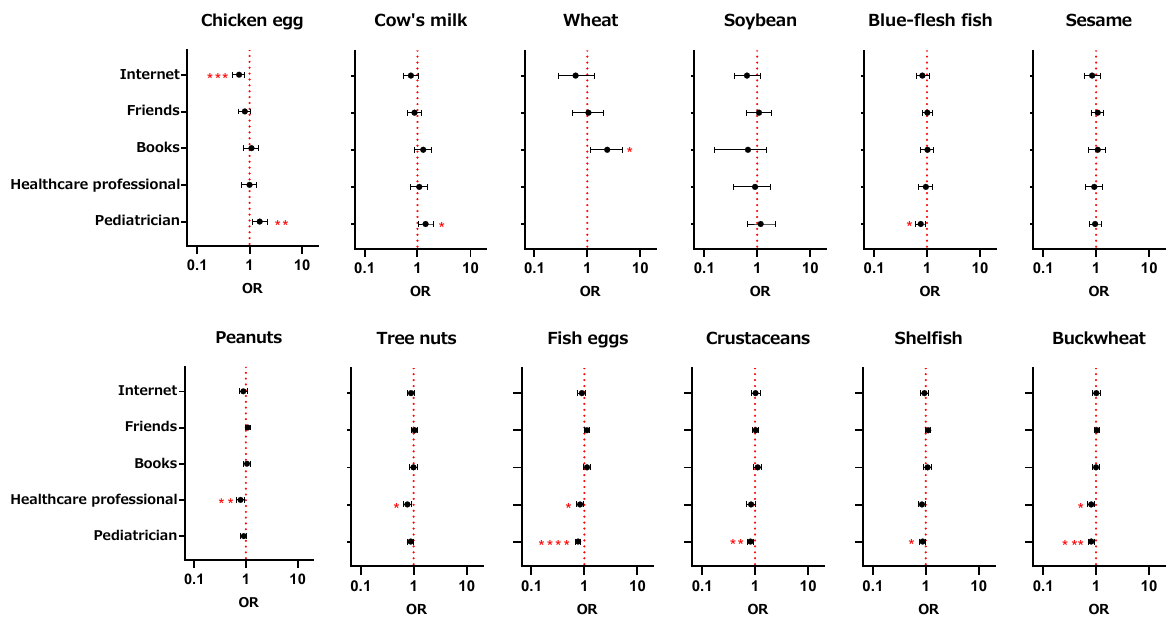
Fig. 3 Association of food avoidance with the caregivers ’ source(s) of medical information by ordinal logistic regression. Separate ordinal logistic regression models were used to determine associations between ordinal outcomes of each food avoidance and the sources of medical information that caregiver sought. Models were adjusted for covariates of medical information sources that care- givers chose in the questionnaire. OR: odds ratios (horizontal bars indicate 95%CI). * P < 0.05, ** P < 0.01, *** P < 0.001, **** P < 0.0001 ORs (95%CI) for “ Healthcare professional ” and “ Pediatrician ” to wheat avoidance outcomes are not shown because the calculations results were